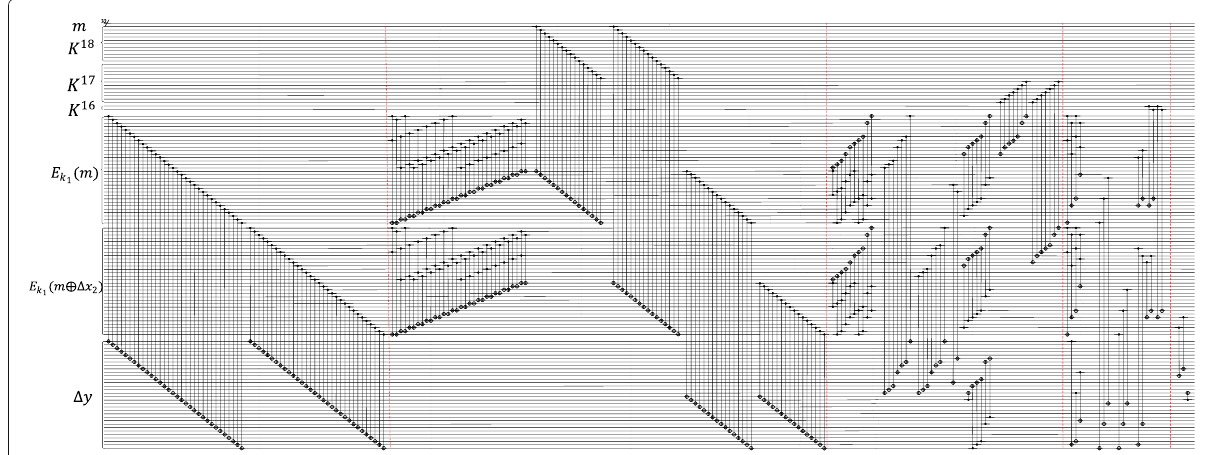
( m ) ⊕ E ( m ⊕ (cid:2) x ) . We use red dotted lines to split the calculation 2 k 1 1